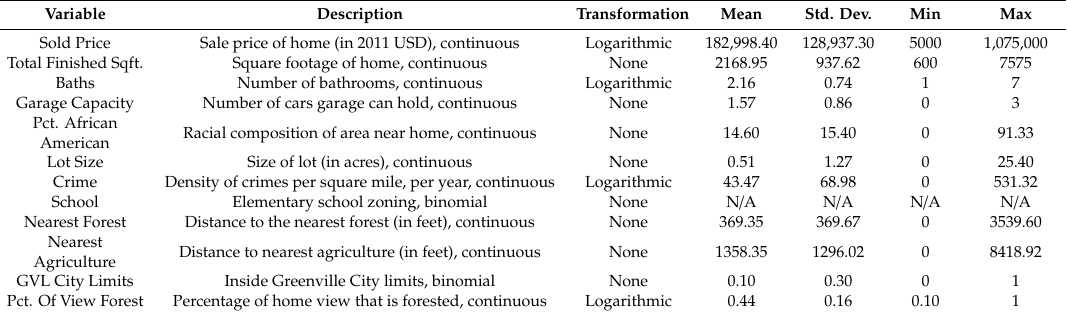
Table 1. Descriptive statistics for variables used in global ordinary least squares (OLS) hedonic model (N =